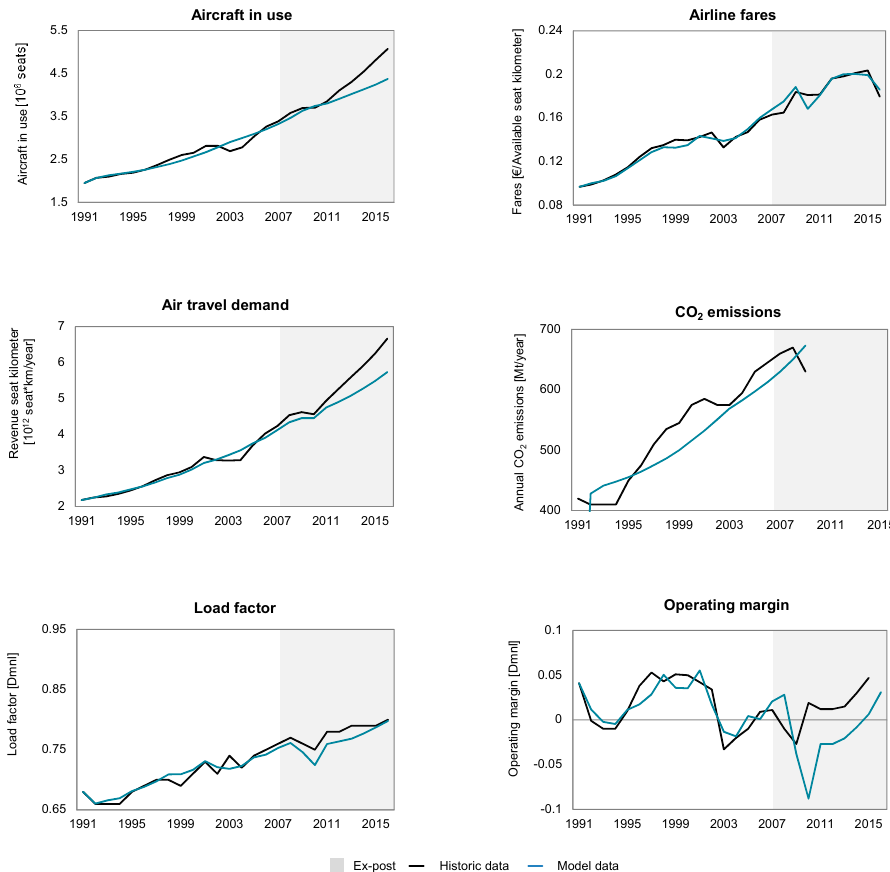
Figure 3. Comparison between model behavior and historic development for aircraft in use, airline fares, air travel demand, CO 2 emission, load factor, and operating margin. Table 2. Theil inequality statistics to compare model behavior with historical data between 1991 and 2016.